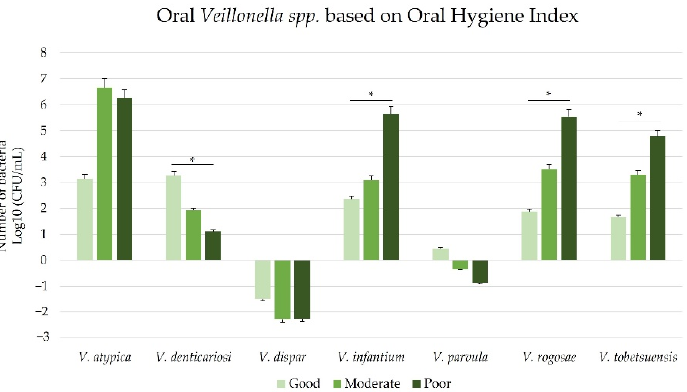
Figure 4. Number of oral Veillonella species based on oral hygiene status. (*) Statistically significant ( p = 0.05).